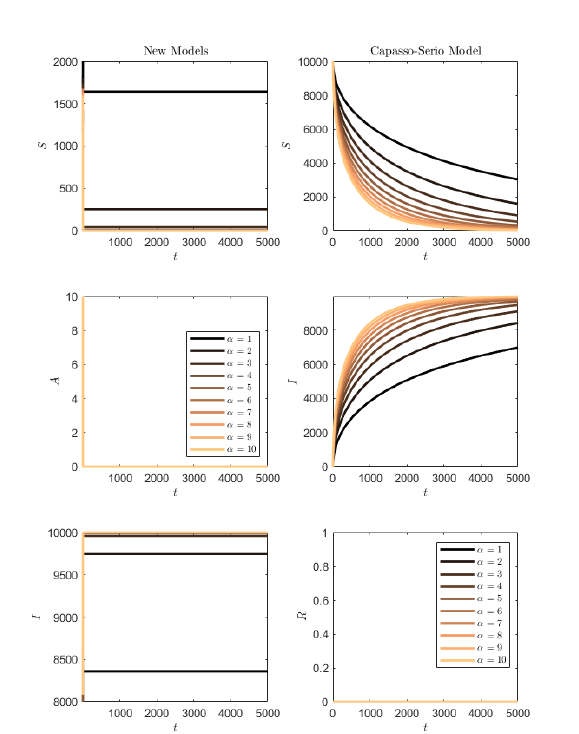
Figure 14. Here, π = 5, γ = 0 and α ∈ [ 1.0,10 ] . It is clearly seen that for α < 5 in the SAI model the susceptibles are preserved, while for transmission rates higher than this threshold, α > π = 5, all individuals eventually become symptomatic. The same occurs in the (73) model independently of α , at a lower pace. Other parameter values are (74) and initial conditions